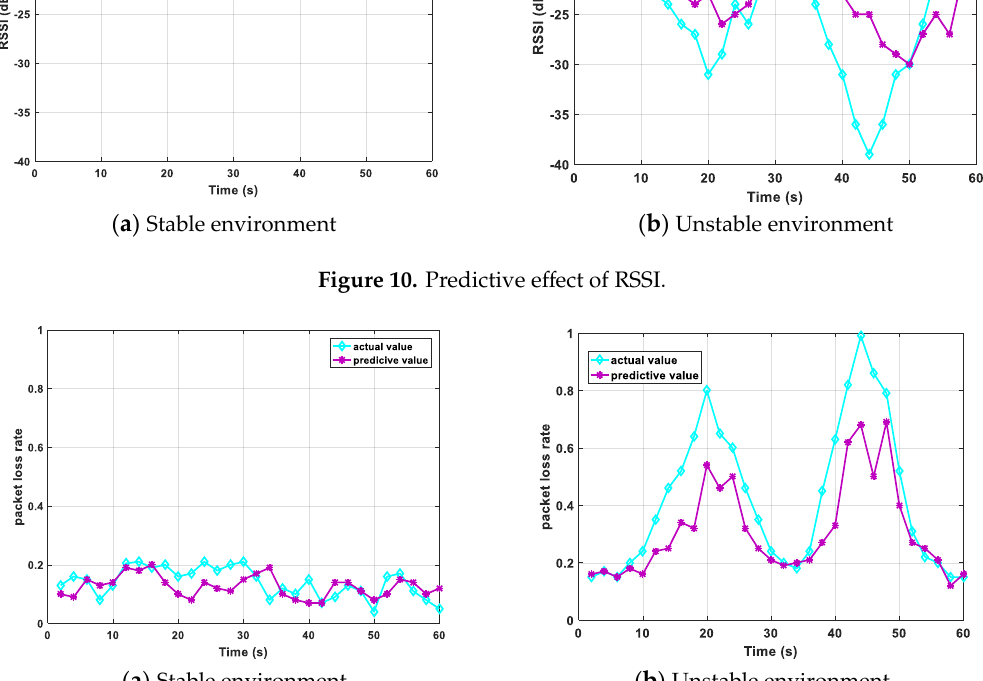
Figure 10. Predictive effect of RSSI.